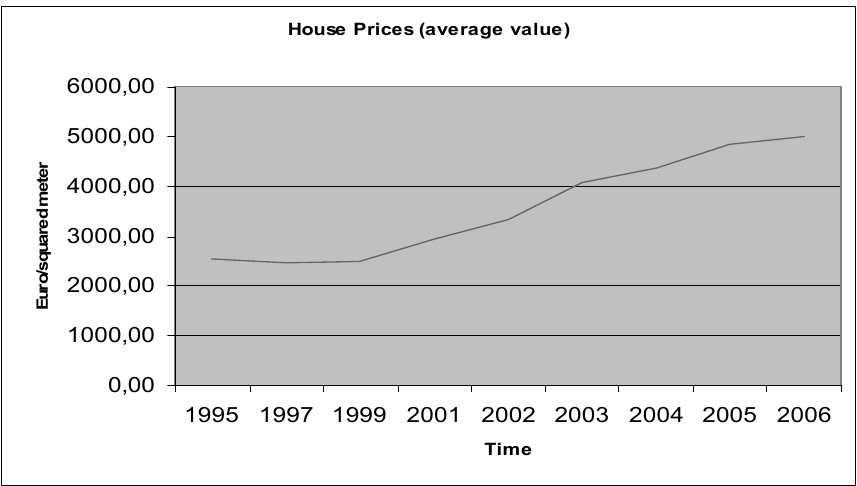
Figure 5b – House Prices (Average Value); our elaboration based on data drawn from “Il Consulente